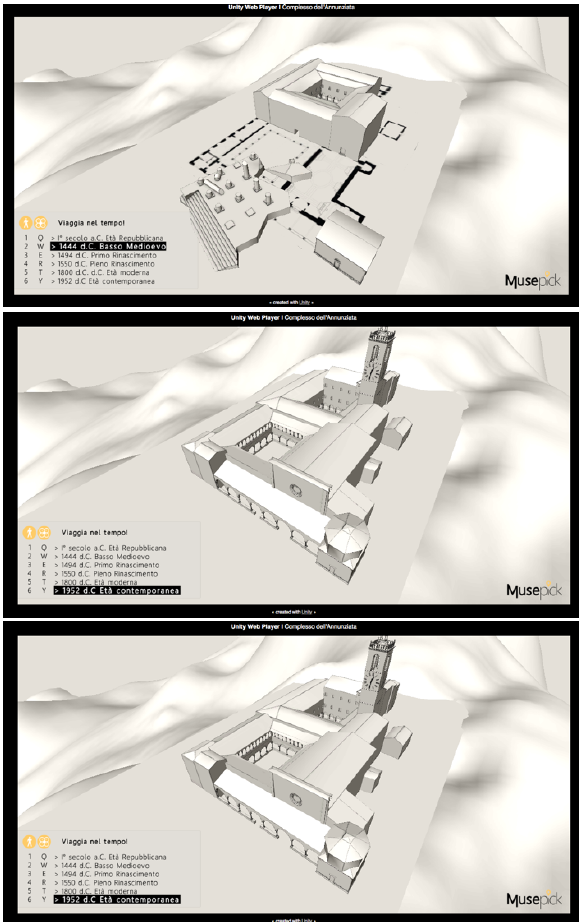
Figure 14. All 3D models used for the immersive walkthrough